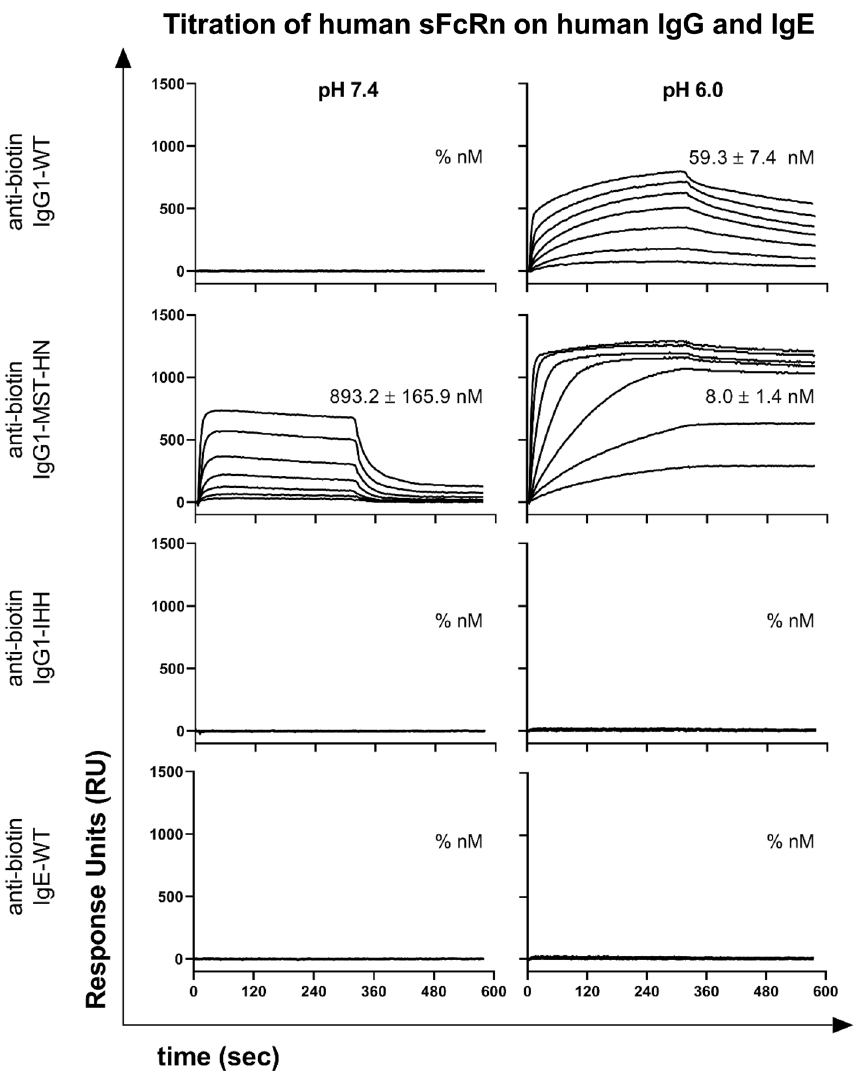
Figure 2. Titration of human sFcRn in SPR reveals no binding to IgE at pH 7.4 or 6.0. Anti-biotin IgG variants and IgE were captured on a sensor with different concentrations of BSA-biotin spotted, leading to comparable levels of antigen-bound IgG and IgE (not shown due to blank subtraction). Human sFcRn was injected in a twofold serial dilution covering a concentration range from 15.63 to 1000 nM and K D values were calculated fitting a 1:1 Langmuir binding model after blank subtraction. A representative of three independent experiments is